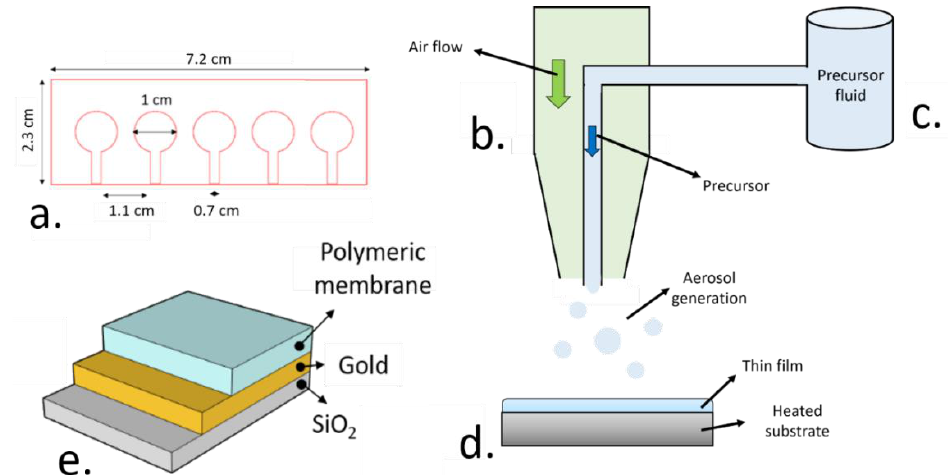
Figure 1. ( a ). Schematic representation of the methacrylate mask employed for the deposition of the sensitive polymer films. ( b ). Representation of the aerosol-assisted chemical deposition (AACD) process, including a pneumatic atomizer nozzle, where the aerosol is generated by using an air flow. ( c ). Such precursor solution is stored in a reservoir at atmospheric pressure. ( d ). The thin gold electrode films generated by plasma sputtering using the methacrylate mask are used as substrate for the deposition of the polymeric sensing films. ( e ). The final device consisted of the silica glass substrate where the thin gold electrodes were deposited along with the plasticized polymeric sensing film.